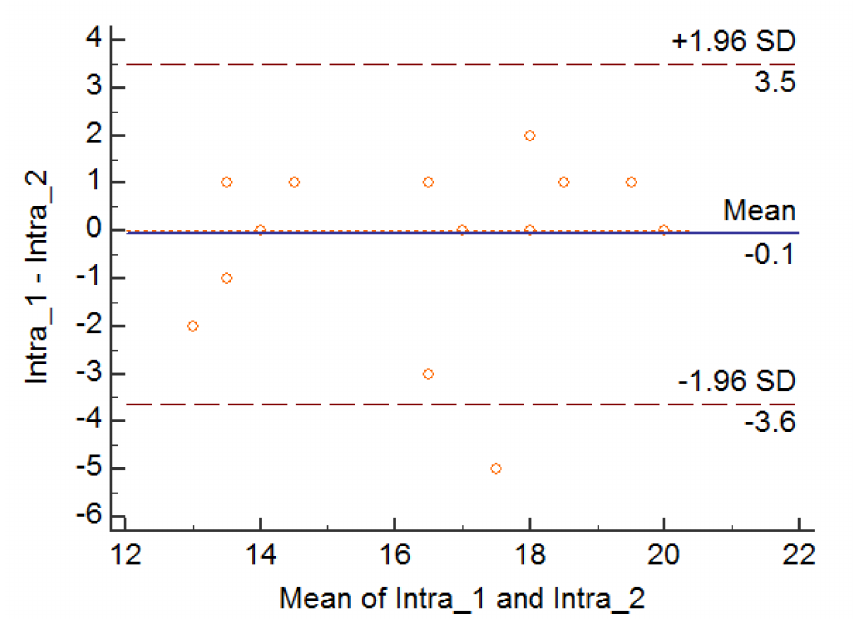
Figure 2 - Bland & Altman Confidence limits. One outlier was excluded. Reviewer Intra_1 = 1 at first; Reviewer Intra_2 = 1 in the second time, two months later.